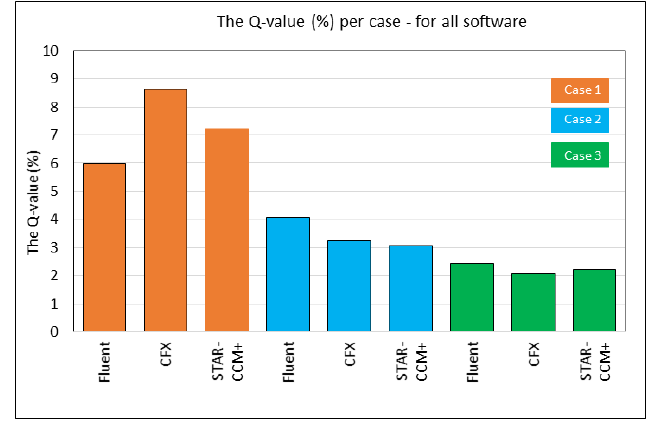
Figure 15. Comparison of the Q-values (%) (Equation (2)) per case for each software. Case 1 results in the highest values, whilst Case 3 results in the lowest values (<2.5%) with all software showing very similar values (<0.5%) difference between the software.